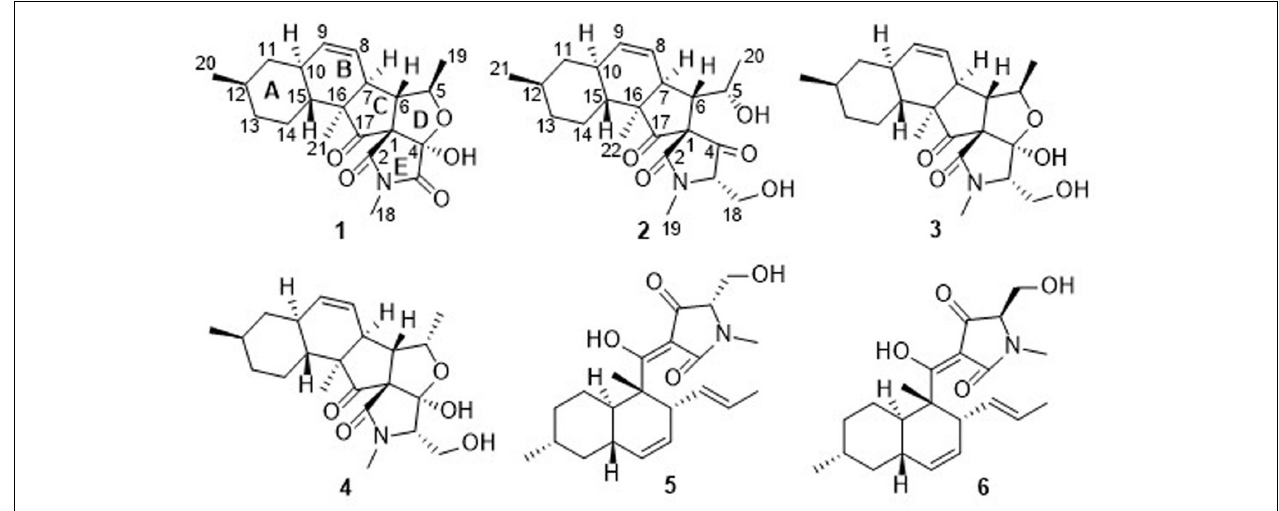
FIGURE 1 | Chemical structures of 1–6